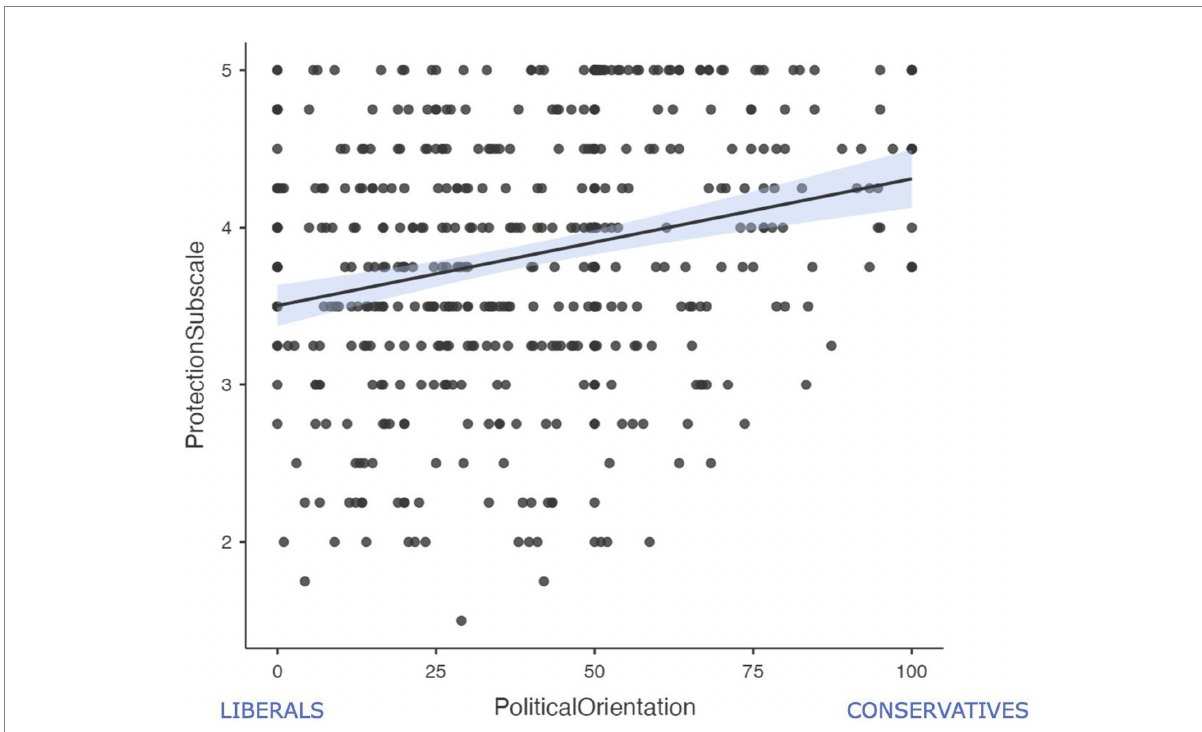
FIGURE 1 Correlation between the self-reported political orientation and the scores on the Protection